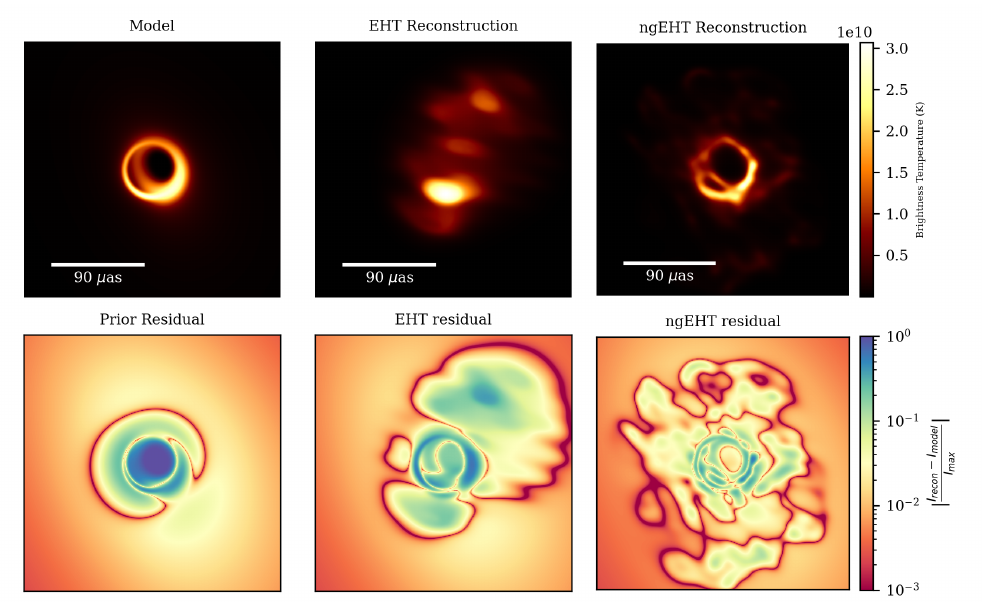
Figure 11. Same as in Figure 10, but using the snapshot reconstructions of SgrA* on April for a 1-h period with maximum coverage. Note that the reconstructions are in a linear scale, while the residuals are in a log